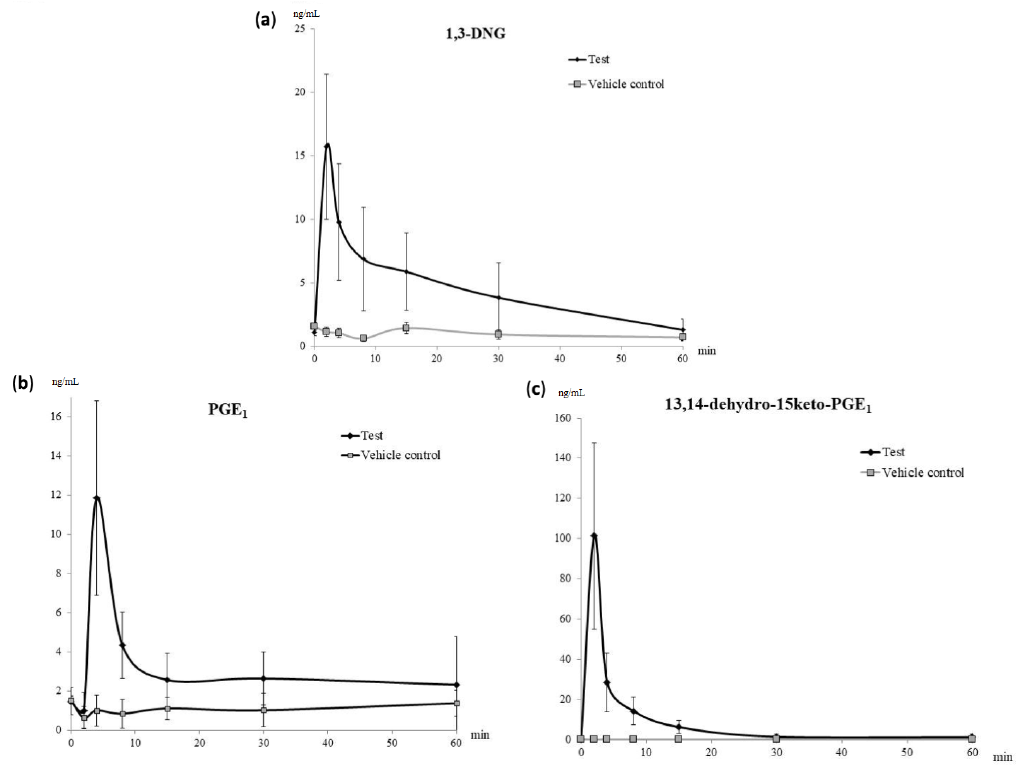
Figure 1. Pharmacokinetic curves of the main Prostanit metabolites found in the plasma of treated and vehiclecontrolrabbits. ( a )Thepharmacokineticcurveof1,3-dinitroglycerol(1,3-DNG);( b )pharmacokinetic curve of prostaglandin E 1 (PGE 1 ); ( c ) pharmacokinetic curve of 13,14-dihydro-15-keto-PGE 1 , N = 6